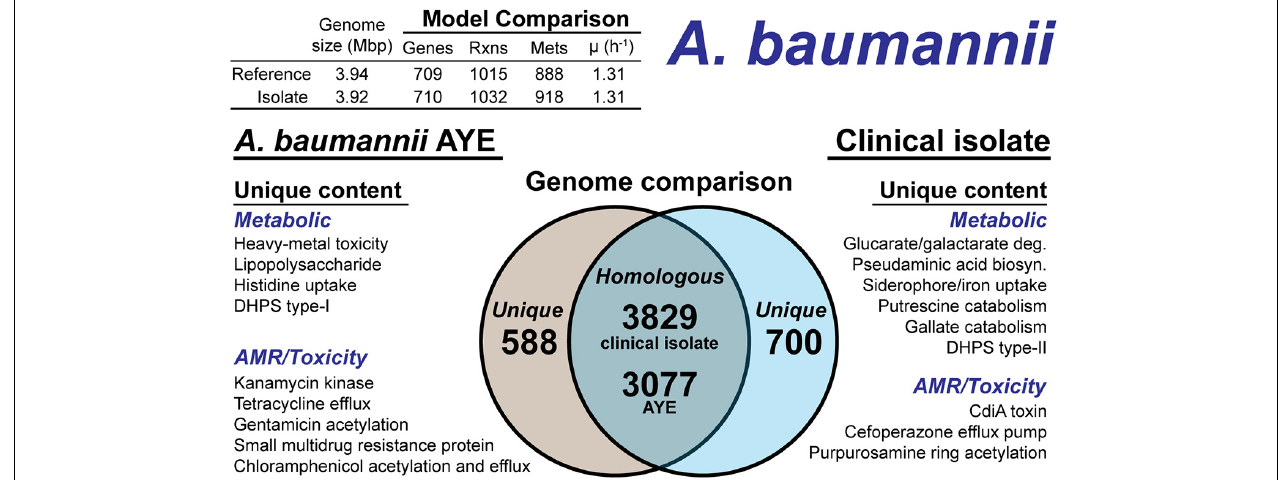
FIGURE 5 | Comparison of A. baumannii AYE versus the A. baumannii clinical isolate based on outputs of the genome-scale metabolic reconstruction